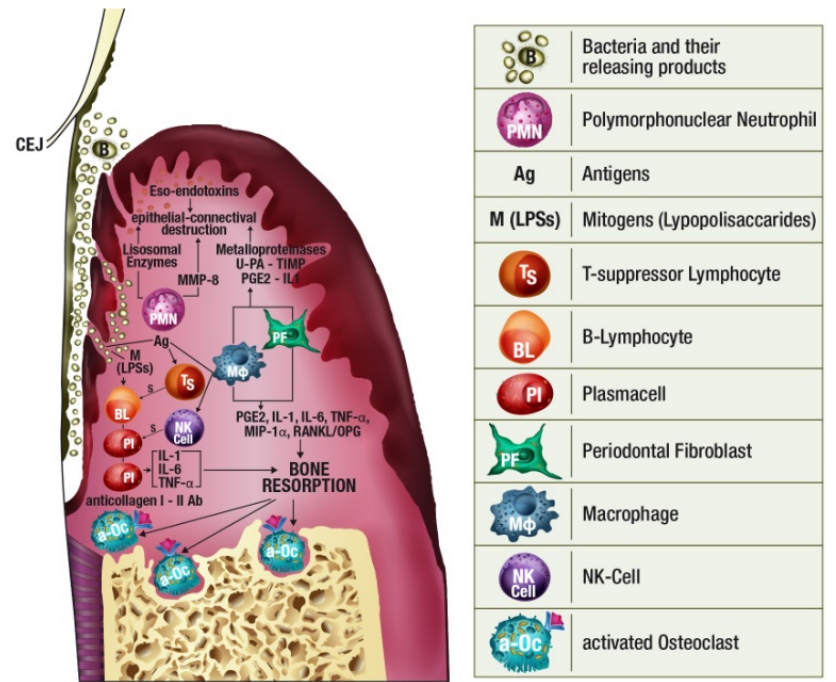
Figure 2. Polymorphonuclear (PMN) leukocytes, representing the first line of defense of periodontal tissues. They release several products during the immune reaction. MMP-8 determines degradation of type I, II, and III collagens.